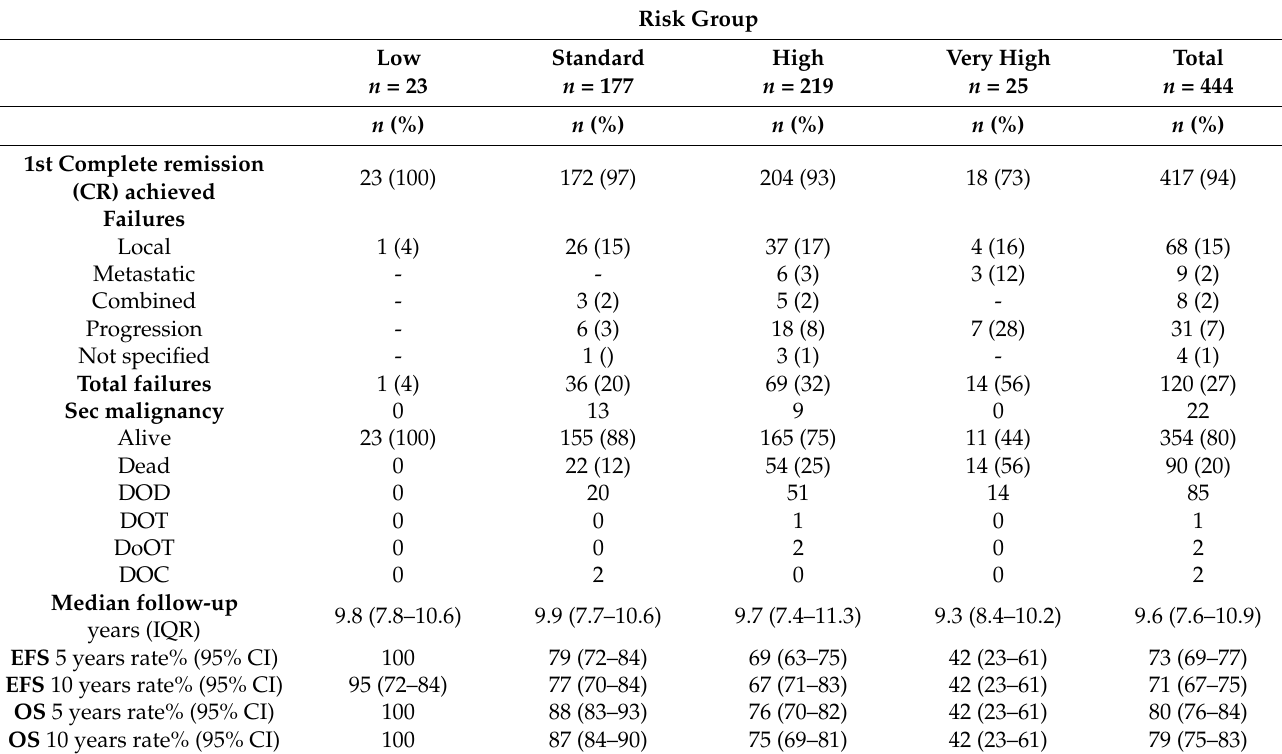
Table 3. Failures and survival parameters by risk groups.